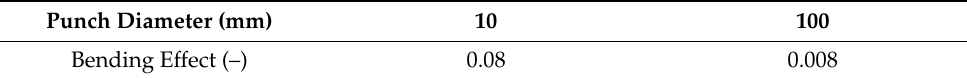
Table 3. Results of bending effect calculation according to Affronti [26].